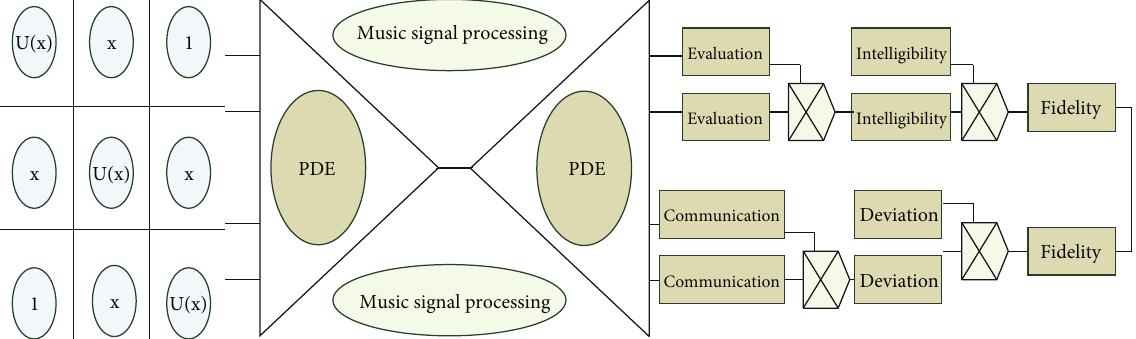
Figure 2: Schematic diagram of music signal recognition algorithm.